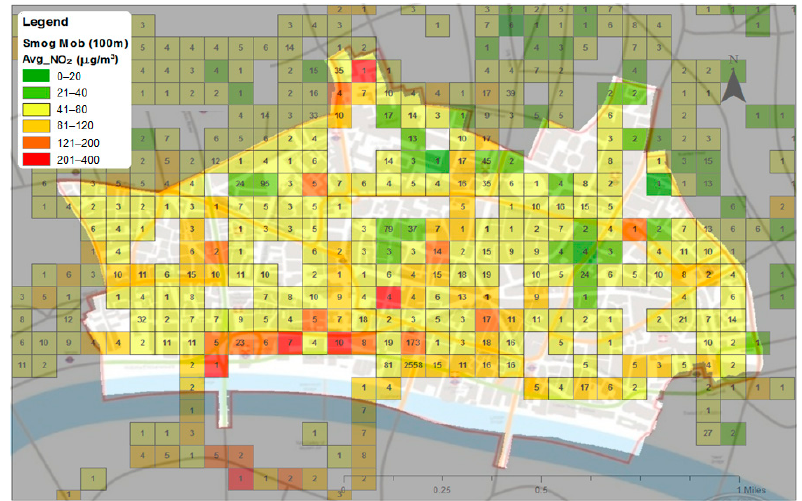
Figure 3. Smogmobile Density Plot (100 m grid resolution) with overlaying background of major roads.